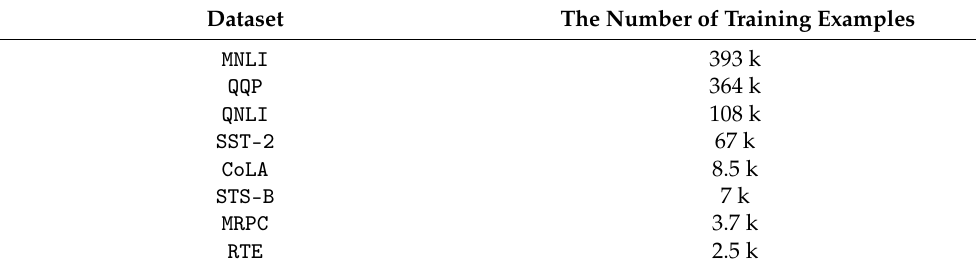
Table 1. Number of training